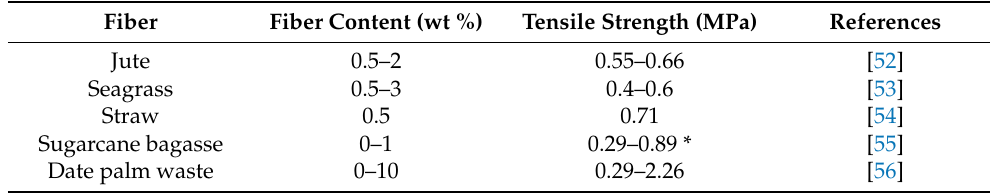
Table 4. Natural fibers used for bricks and tensile strength of earth bricks.